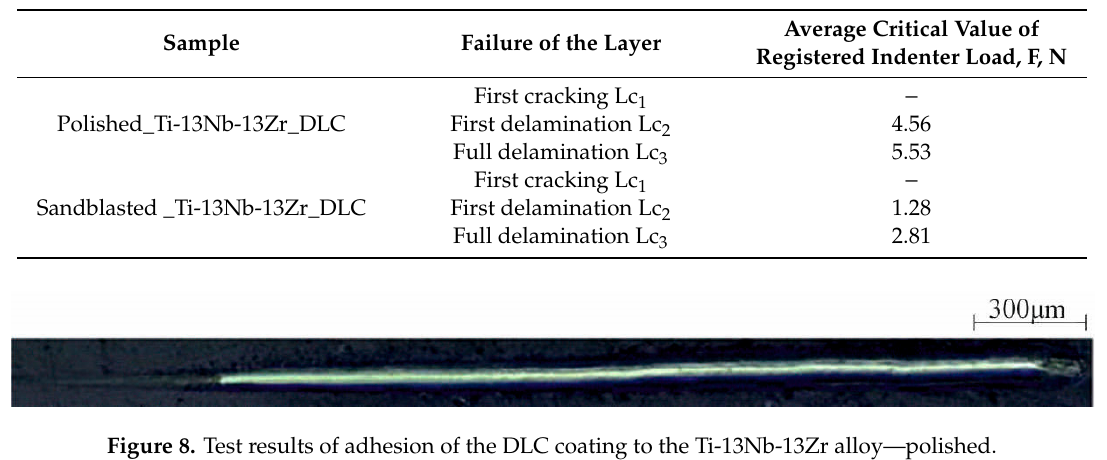
Figure 7. Depth profile of microhardness for the DLC coating applied onto the Ti-13Nb-13Zr alloy.